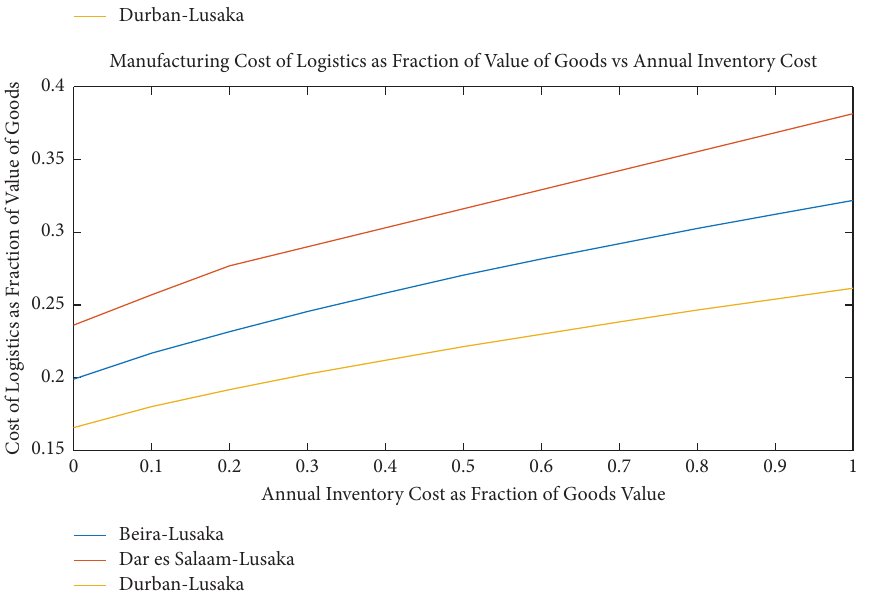
Figure 7: Logistics cost is a fraction of the value of goods for diferent values of annual inventory